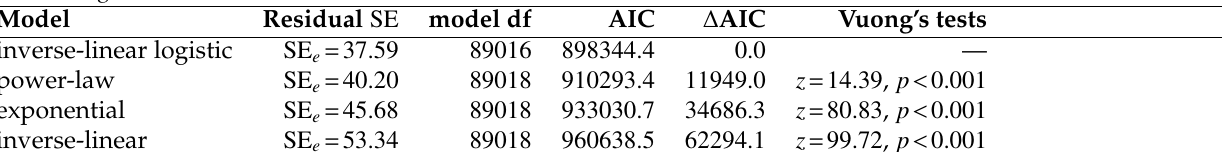
Tests of nonlinear model fits to saccades . For all ∆ AIC the inverse-linear logistic model is the base as it yields the smallest AIC criterion. Vuong’s tests (last column) compare all other models to the inverse-linear logistic fit. Data from Experiment 3 (free viewing @ 500 Hz).